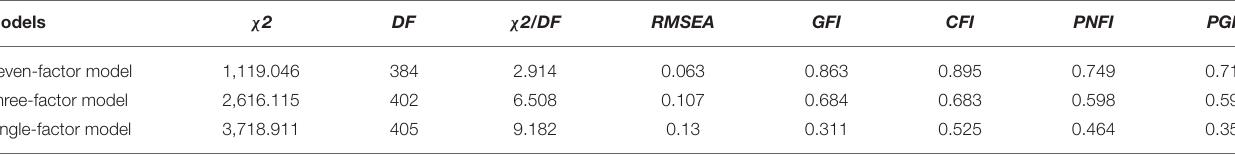
TABLE 2 | Goodness-of-fit index of the measurement model.